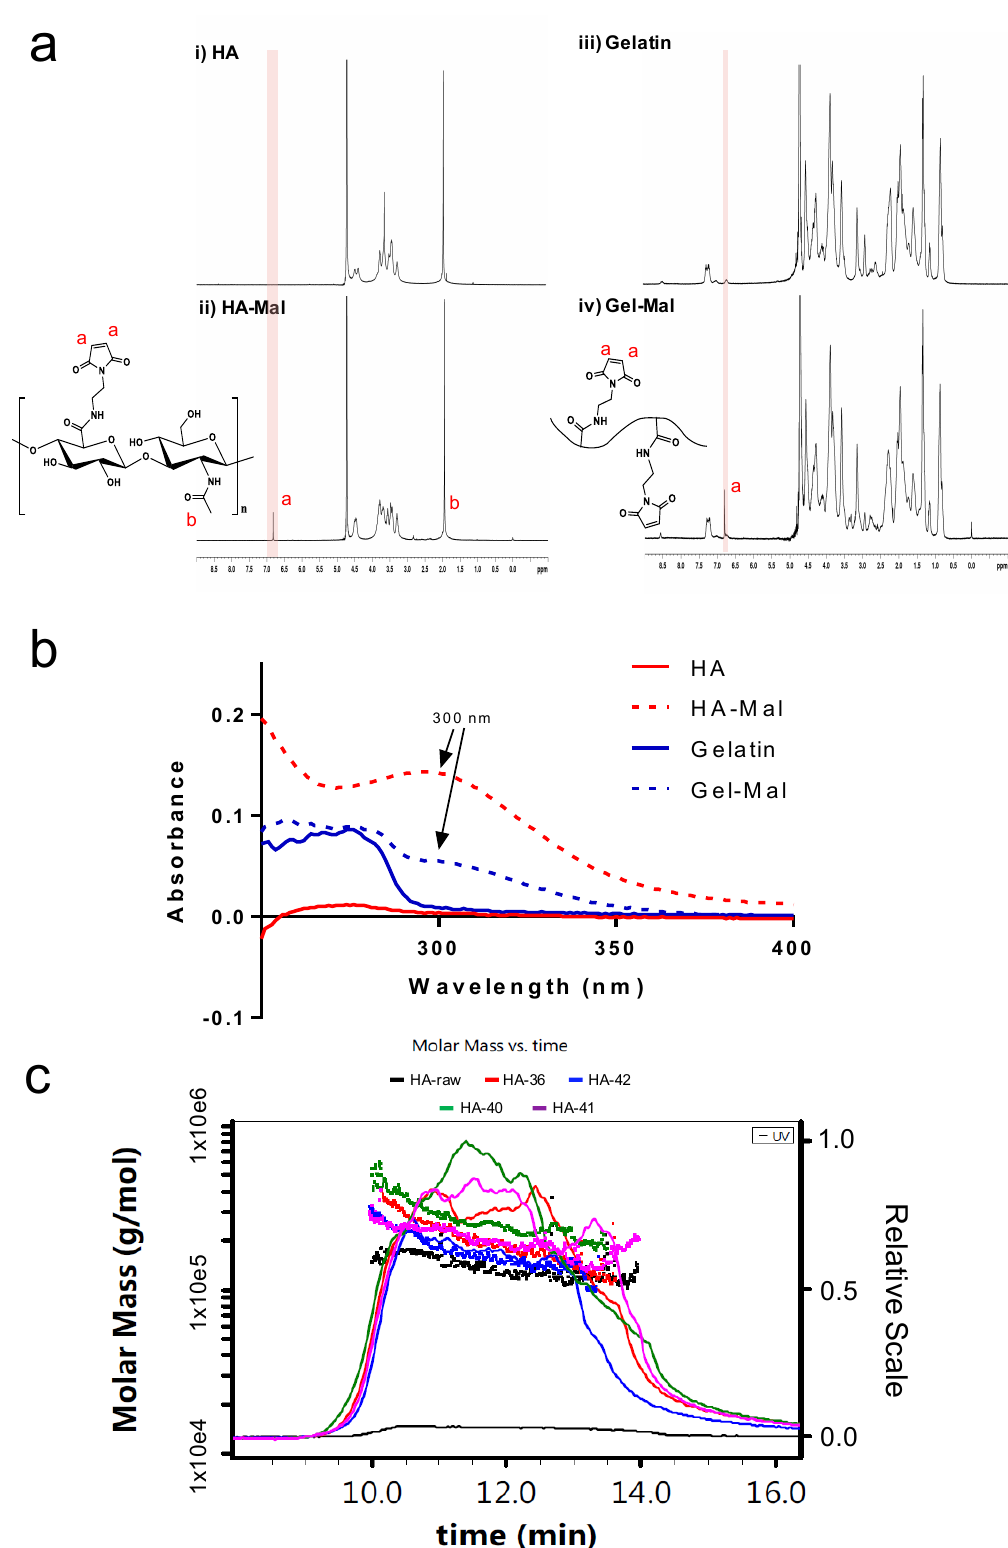
Figure 2. Chemical characterization of HA-Mal and Gel-Mal. ( a ) 1 H NMR spectrum of unmodified HA and HA-Mal (left) and unmodified gelatin and Gel-Mal (right). The peak corresponding to the maleimide hydrogens (red ‘a’) is at 6.8 ppm. ( b ) UV–Vis absorption spectrum (200–400 nm) for HA, HA-Mal, Gelatin and Gel-Mal. Maximum absorbance values of the maleimide group in both HA-Mal and Gel-Mal occurred at a wavelength of 300 nm (black arrow). ( c ) SEC-MALS spectrum of HA and HA-Mal for MW